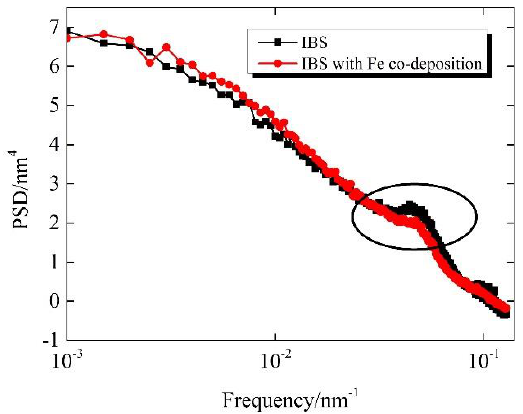
Figure 5. PSD of sapphire after 1000 eV Ar + bombardment at a fixed incidence angles 65°, with beam density 487 μ A/cm 2 . ( a ) patterns bombarded with a pure ion beam ( b ) patterns bombarded with simultaneous Fe co-deposition and taken at a position 2 cm from the Fe target.